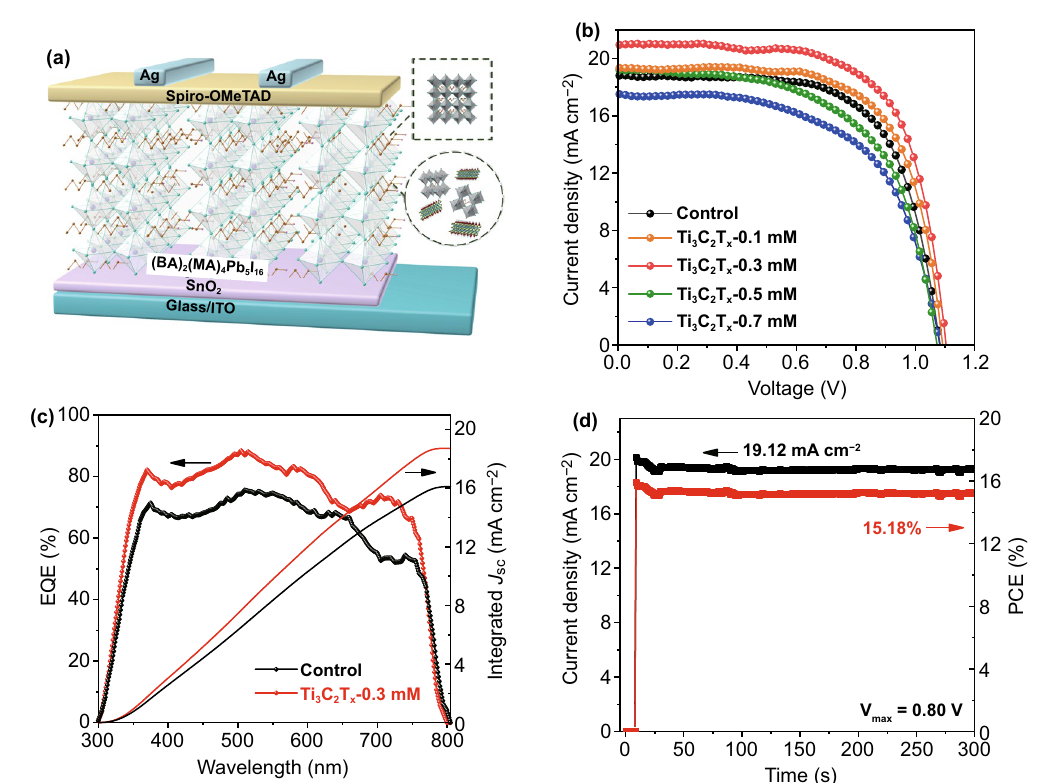
Fig. 2 a Schematic diagram of devices with the structure of Glass/ITO/SnO 2 /2D perovskite/Spiro‑OMeTAD/Ag. b J–V curves of devices with different amounts of Ti 3 C 2 T x ‑doping. c EQE spectra and integrated J sc of the control and optimized Ti 3 C 2 T x ‑doping devices. d Stabilized power output and current density at a constant bias of 0.80 V for the Ti 3 C 2 T x ‑doping devices